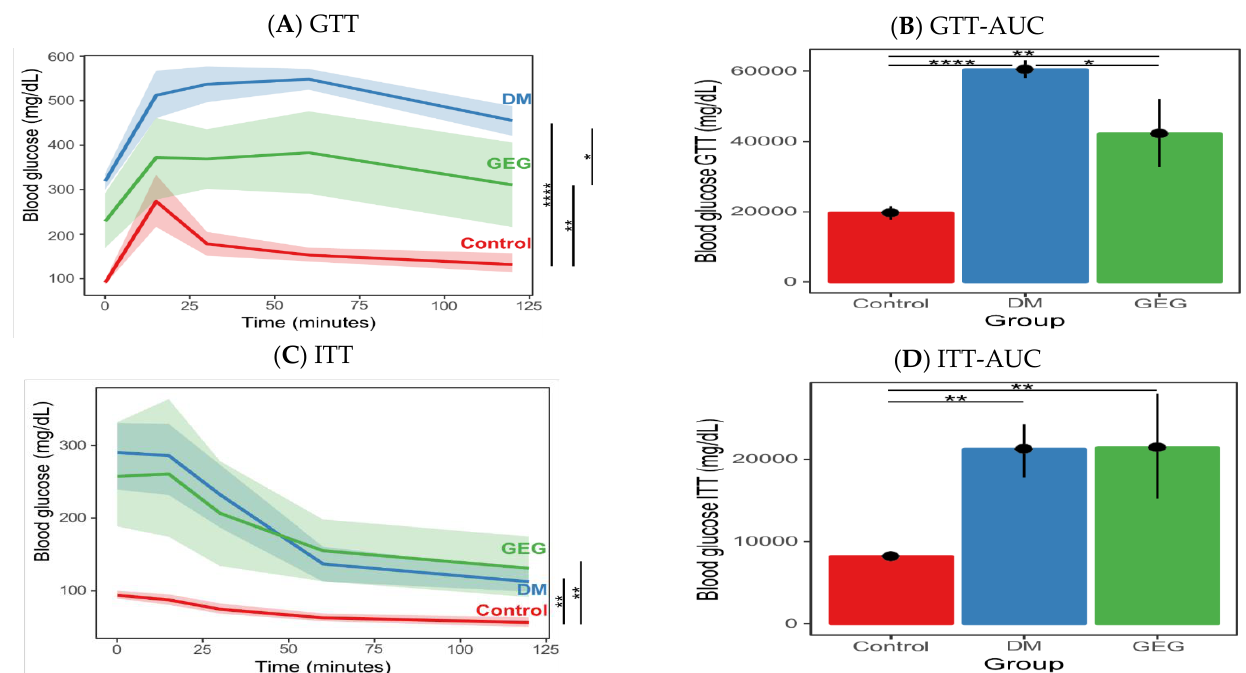
Figure 2. Effect of gingerol-enriched ginger (GEG) on blood glucose during ipGTT ( A ), ipGTT AUC ( B ), blood glucose during ipITT ( C ), and ipITT AUC ( D ). Data is presented as mean with error bars or ribbons indicating 90% confidence interval. One-way ANOVA was used, followed by Tukey’s HSD in R environment. n = 6 – 8 per group. * indicates p < 0.05, ** p < 0.01, and **** p < 0.0001.